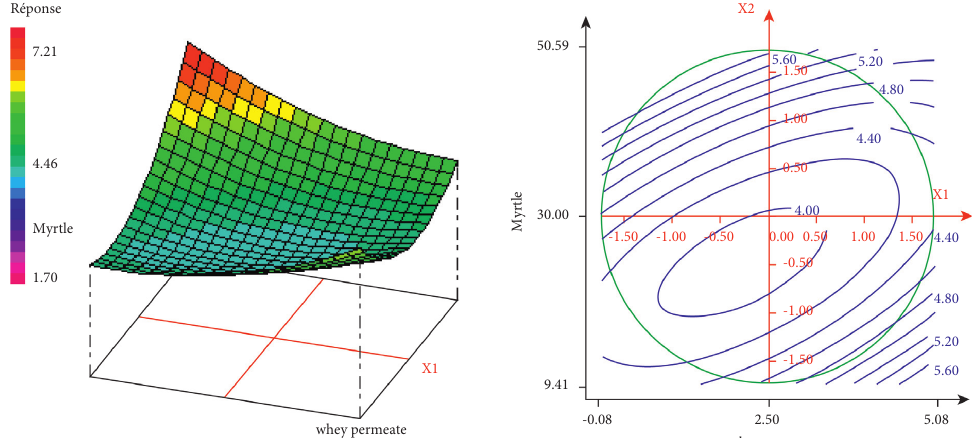
1 : WP (% w/v) and X 2 : MJ (%